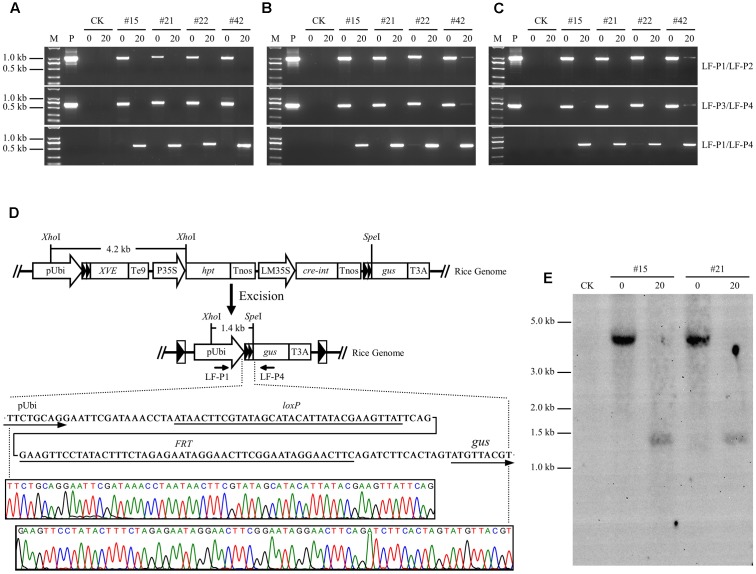
Molecular characterization of chemical-induced site-specific DNA recombination in LF-GUS transgenic rice plants. (A–C) PCR analysis of genomic DNA extracted from the roots (A), stems (B), and leaves (C) of LF-GUS plants. M, DNA molecular marker; P, plasmid control pXCLF-GUS; CK, non-transgenic wild type control; #15, #21, #22, and #42, pXCLF-GUS-transformed rice line #15, #21, #22, and #42; 0, plants developed from seeds soaked and germinated in liquid solution with 0 μM estradiol; 20, plants developed from seeds soaked and germinated in liquid solution with 20 μM estradiol. (D) Sequence confirmation of site-specific DNA recombination in the genome of induced LF-GUS plants. The diagram represents the putative reconstituted structure after recombination between two loxP-FRT sites. Sequence below the diagram indicates the predicted nucleotide sequence of the junction regions at the recombined loxP-FRT site. The bottom chromatogram shows sequencing results of the LF-P1/LF-P2 amplified product from induced LF-GUS plants. (E) Southern blot analysis of genomic DNA extracted from leaves of LF-GUS plants. CK, non-transgenic wild type control; #15 and #21, pXCLF-GUS-transformed rice line #15 and #21; 0, plants developed from seeds soaked and germinated in liquid solution with 0 μM estradiol; 20, plants developed from seeds soaked and germinated in liquid solution with 20 μM estradiol. Rice genomic DNA was digested with XhoI and SpeI. The blot was hybridized with a 3′-end fragment of the maize ubiquitin-1 promoter.